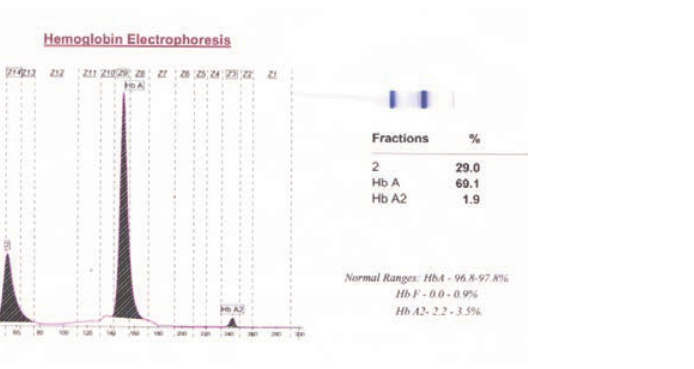
Figure 2. Capillary zone electrophoresis showing abnormal peak in zone 14 correspon- ding to hemoglobin N